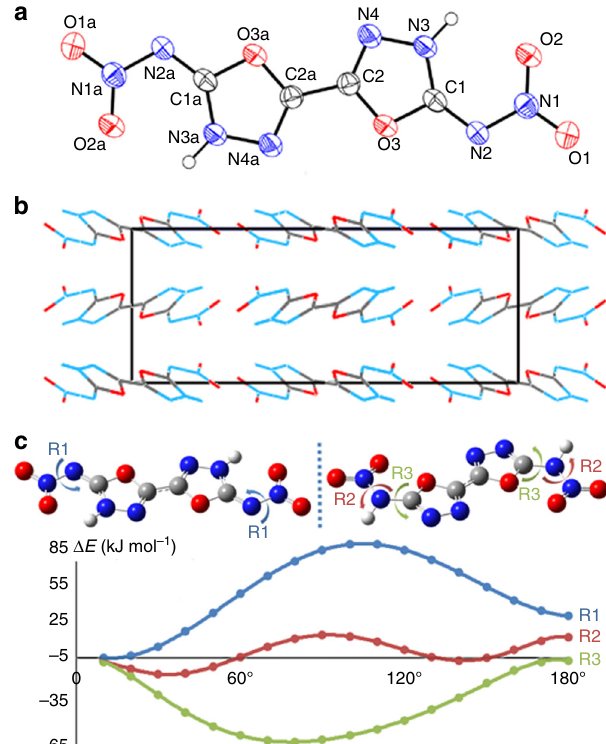
Fig. 2 Crystal structure of ICM-101. a Single-crystal X-ray structure of ICM- 101 with labeling (thermal ellipsoid plot: 30%). b Crystal packing of ICM- 101 viewing down the unit cell axis b . c The relative energies of ICM-101 as a function of the rotation of the nitro groups (R1) in comparison with the relative energies of ICM-101 tautomer (protons bond to N2/N2a) as a function of the rotation of the nitro groups (R2) and nitroamine groups (R3). The initial structure for ICM-101 and its tautomer were obtained from crystal structure or set up as planar (rotation angle equal zero), respectively